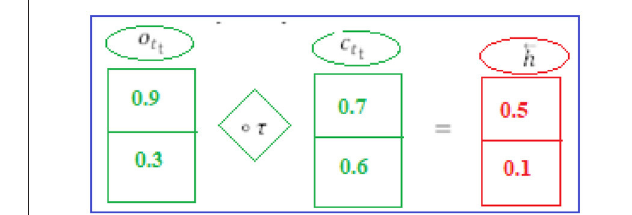
FIGURE 5 | 2nd hidden layer.